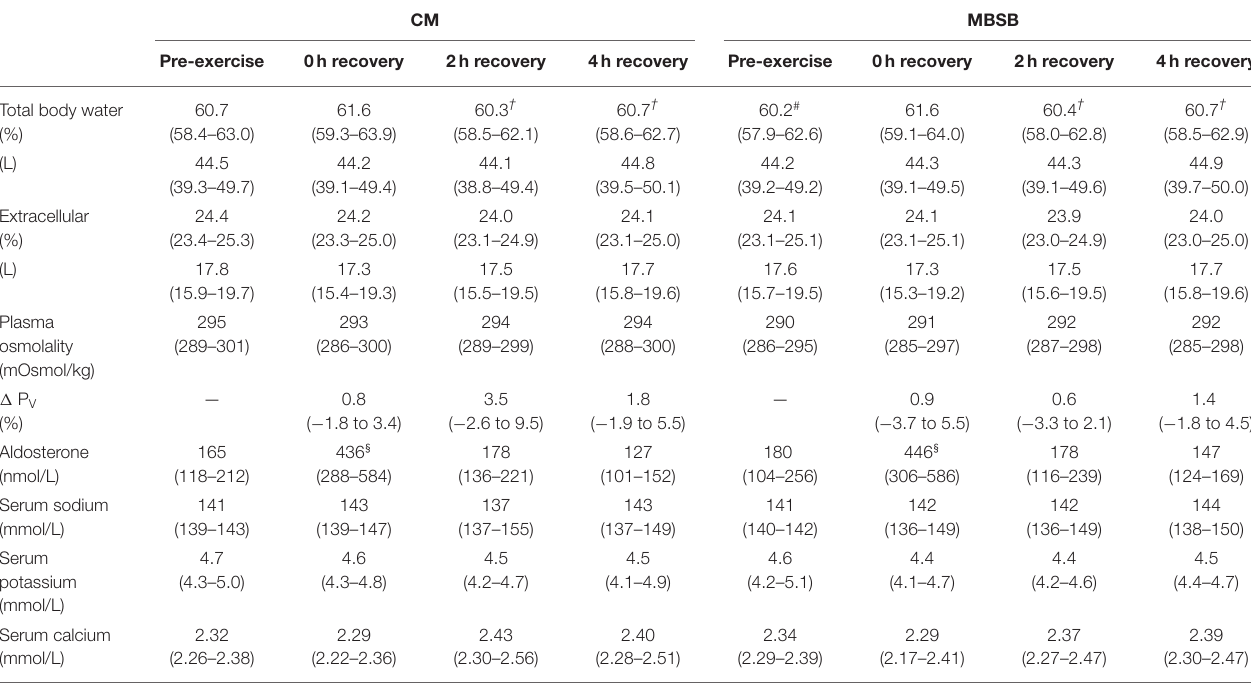
TABLE 3 | Change in hydration markers in response to 2h HIIT exercise (between 60 and 80% V O 2max ) in temperate ambient conditions and after consumption of a whole food dairy milk beverage (CM) and a reconstituted milk based supplement beverage (MBSB).